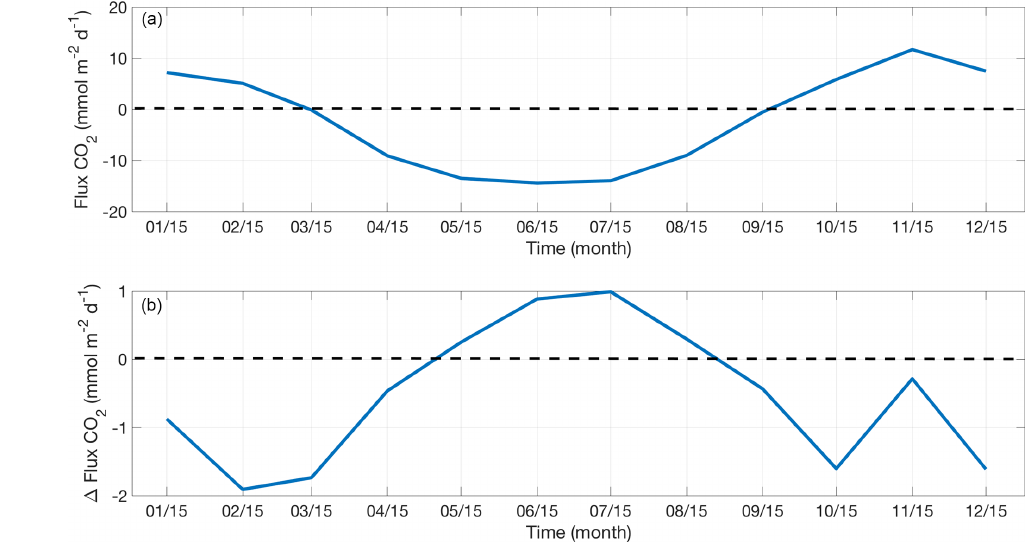
Figure 6. Average (a) of the air–sea CO 2 flux and (b) of the difference between the coastal region and open sea from 1998 to